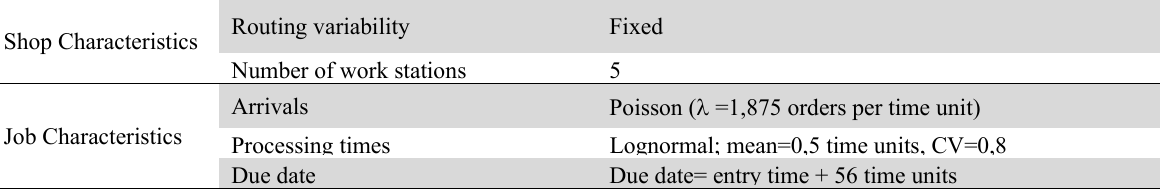
Shop and Job Characteristics of the simulation model Shop